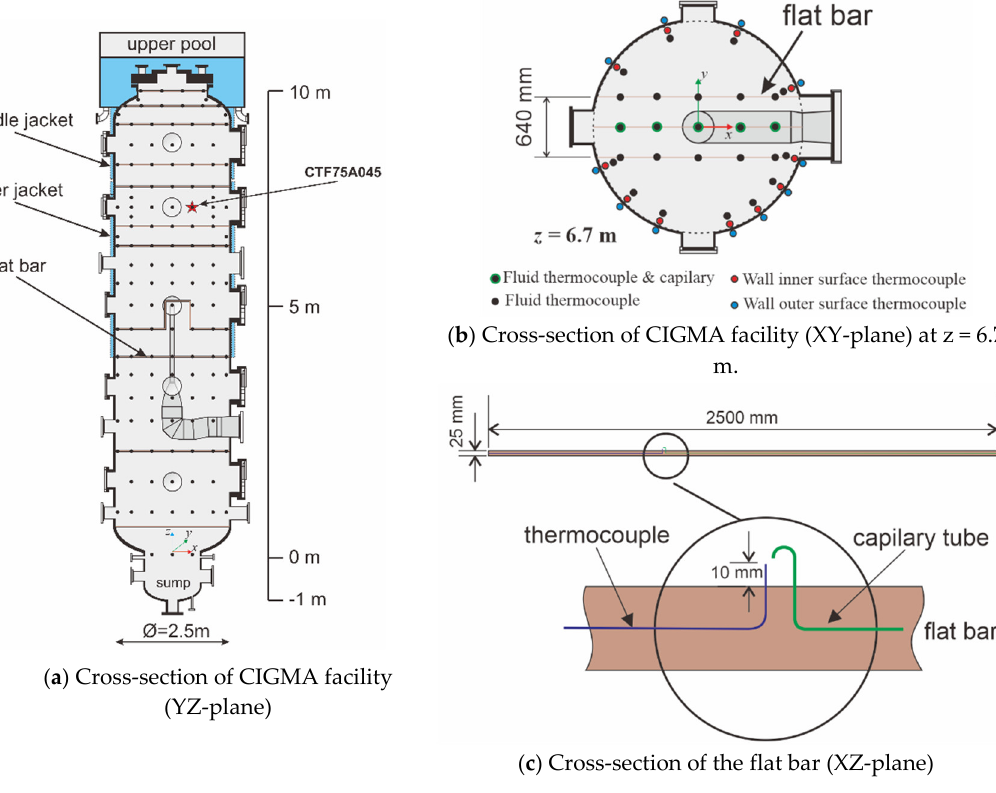
Figure 1. The schematic drawing of the a Containment InteGral Measurement Apparatus (CIGMA) facility at Japan Atomic Energy Agency (JAEA). Table 1. Experimental conditions.